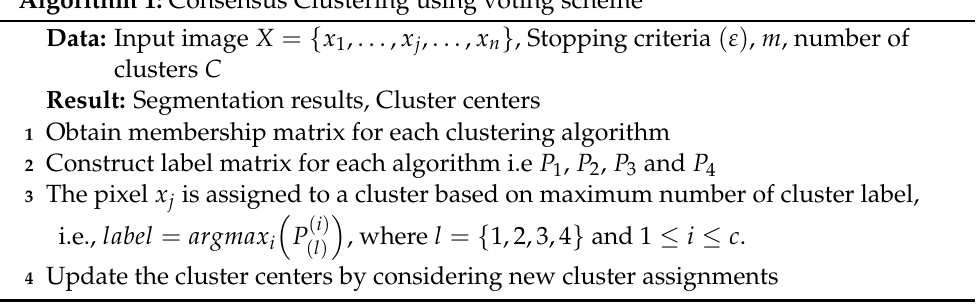
Algorithm 1: Consensus Clustering using voting